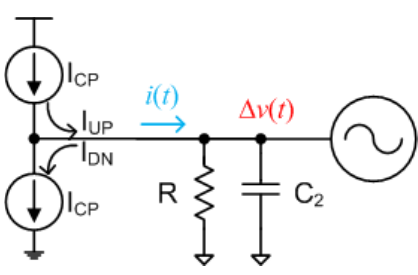
Figure 7. The calculation of the ripple voltage due to R and C 2.